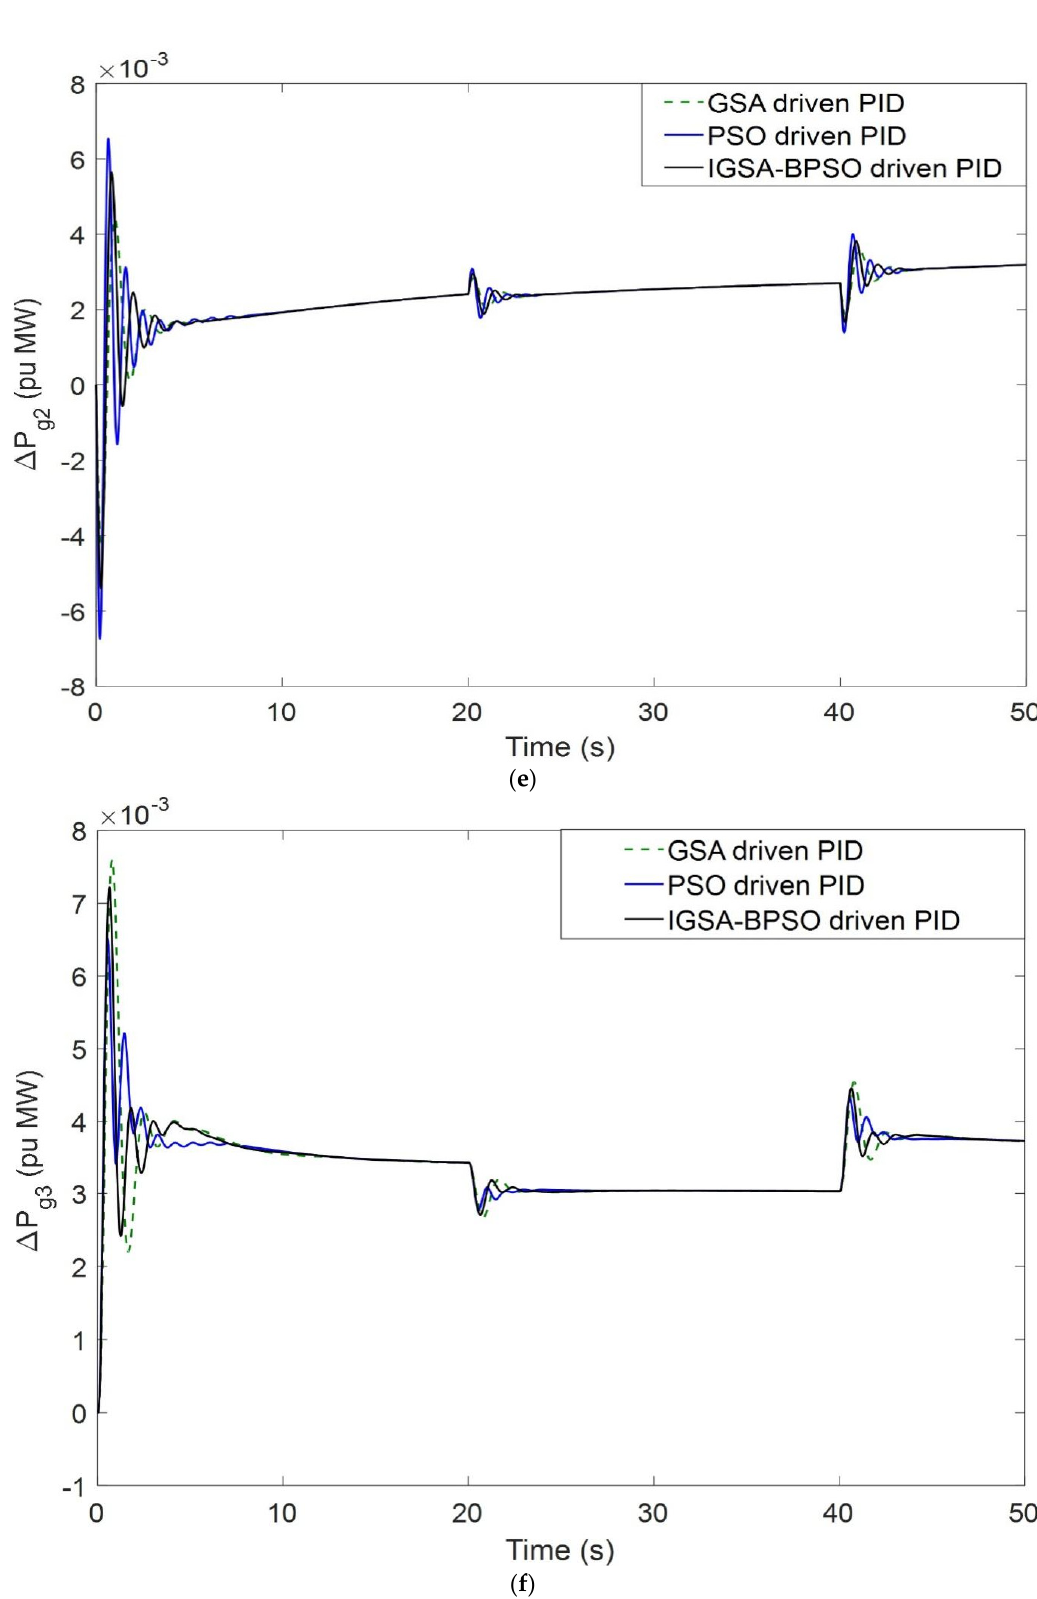
Figure 12. ( a ) Dynamic load changes variation for Δ F 1 related to PBT case; ( b ) dynamic load changes variation for Δ F 2 related to PBT case; ( c ) dynamic load changes variation for Δ P tie related to PBT case; ( d ) dynamic response Δ P g1 for PBT case; ( e ) dynamic response Δ P g2 for PBT case; ( f ) dynamic response Δ P g3 for PBT case.